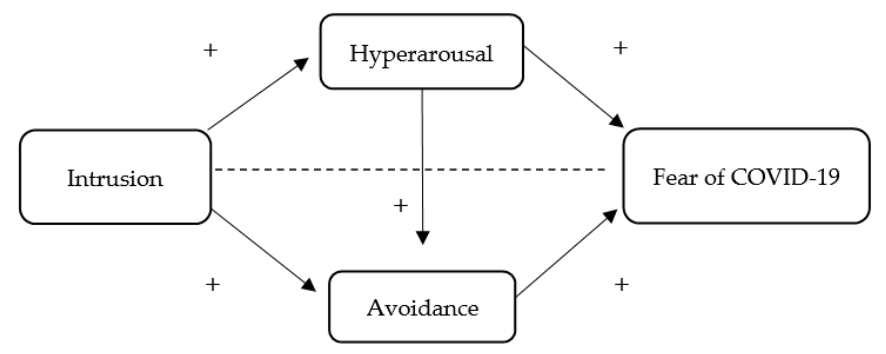
Figure 1. Sequential mediation model proposed to test the associations between intrusive thoughts, hyperarousal, avoidance, and fear of COVID-19 (Study 1). +: positive rela- tionship